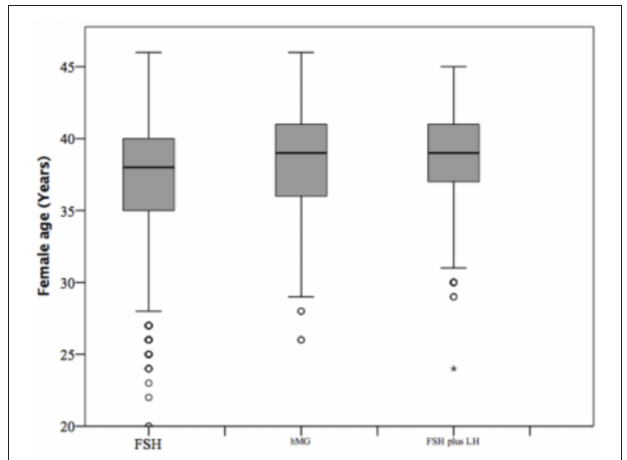
FIGURE 2 | Female age among groups of patients, divided according to gonadotropins regimen chosen.